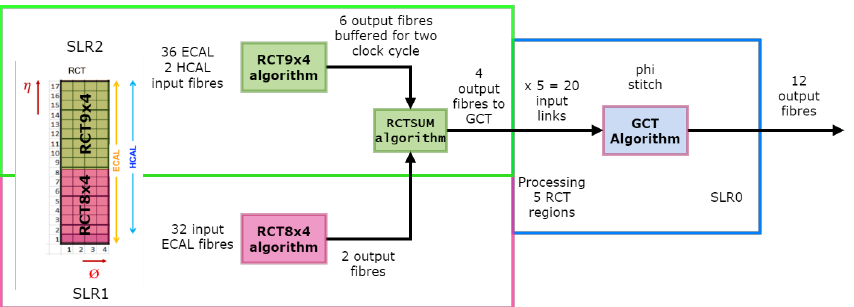
Figure 7. Integrated RCT and GCT algorithm block diagram. The RCT9 × 4, RCTSUM, RCT8 × 4, and the GCT phi stitch algorithms are implemented in SLR2, SLR1, and SLR0, respectively.